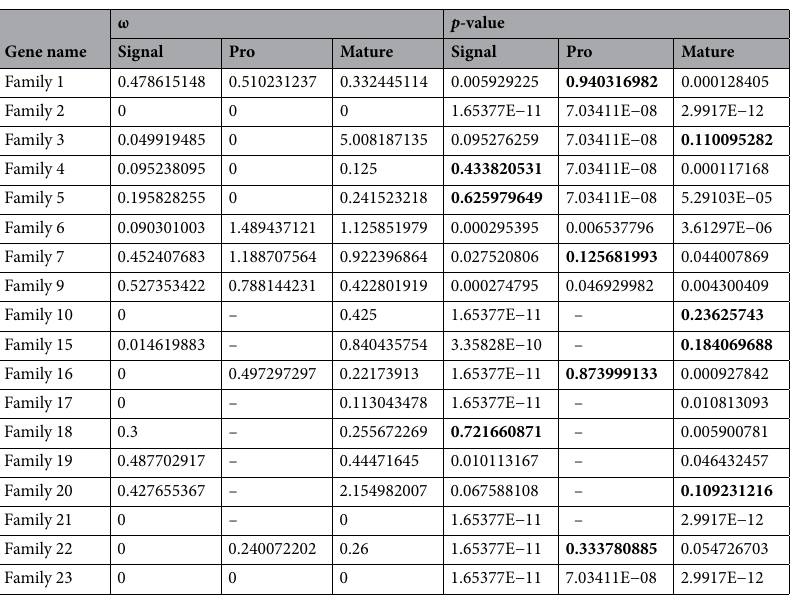
Table 2. Evolution analysis of each family of H. venatoria venoms. The bold background cell represents p -value ≥ 0.1.